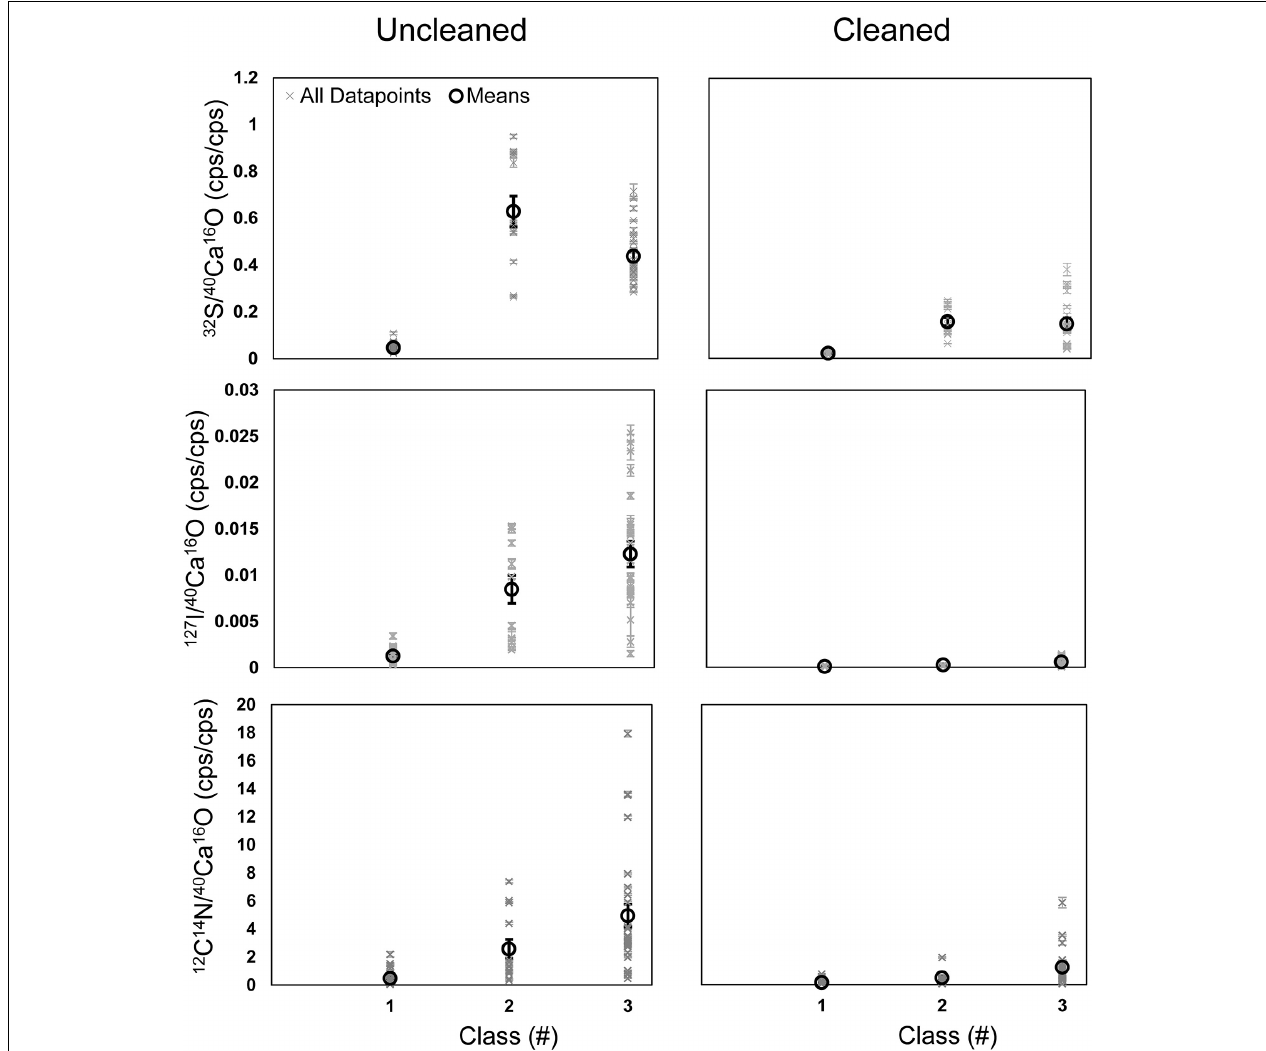
FIGURE 7 | Means (black) and all data points (black) for the 12 C 14 N − / 40 Ca 16 O − , 32 S − / 40 Ca 16 O − , and 127 I − / 40 Ca 16 O − ratios measured on all ROIs on all Nano-SIMS element mappings made on U. striata from the Peruvian OMZ. We compared uncleaned specimens (Left) with specimens that have been treated by an oxidative cleaning before embedding for the preparation of the cross-sections (Right) . Additionally, three different phases within the foraminiferal calcite were compared (class 1–3; see Figure 4 ). Class 1 represents regions of the lowest 32 S − / 40 Ca 16 O − ratios, possibly free of influence from the organic matrix in the tests. Class 2 represents the distinct 32 S − bandings, while class 3 represents the highest 32 S − / 40 Ca 16 O − ratios outside these bandings that is supposed to bear the organic